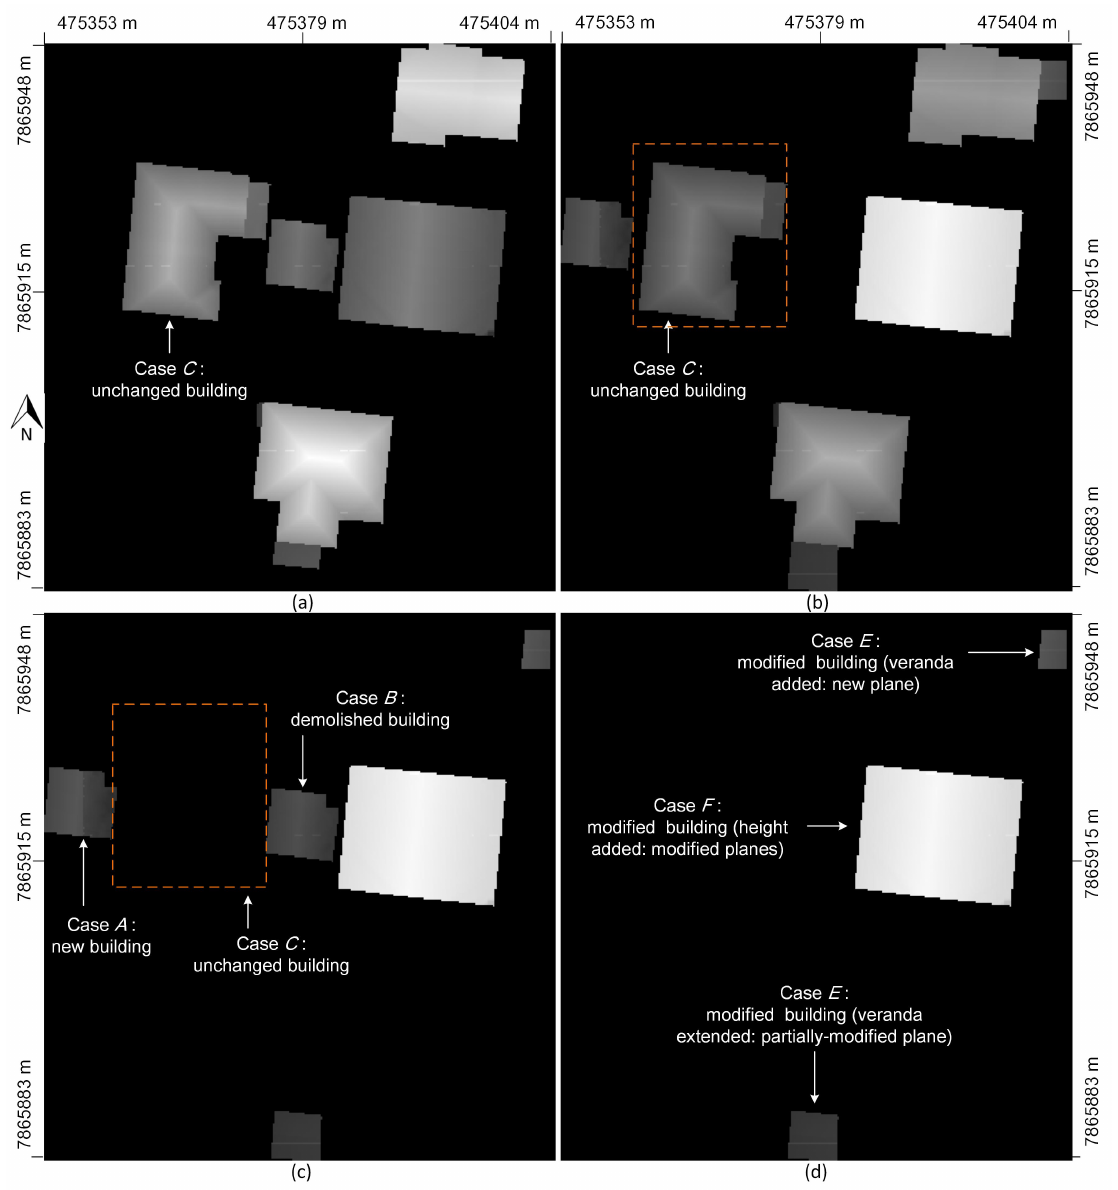
Figure 13. Finding the 3-D plane changes between the reference and test models: Height intensity images for: ( a ) reference models; ( b ) test models; ( c ) absolute height difference image (test minus reference); and ( d ) modified building